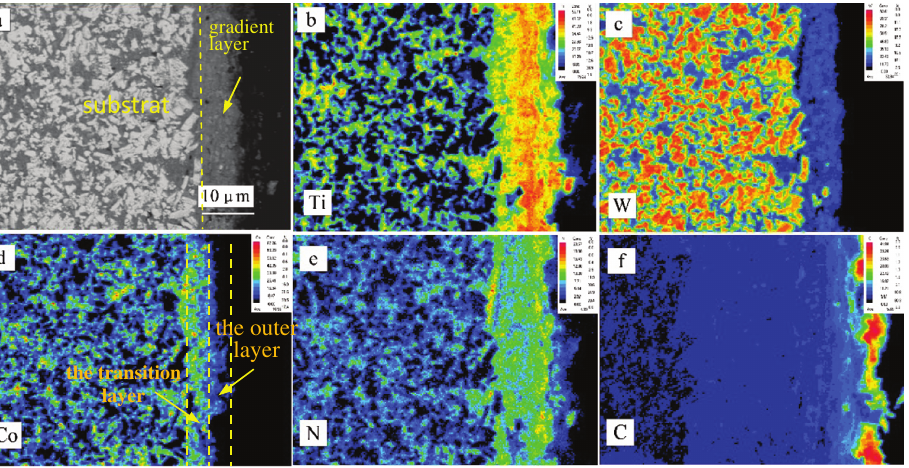
Figure 1: The microstructure of FGCC-T5 cross-sectional metallographic specimens (EPMA, sintering temperature is 1400°C, holding time is